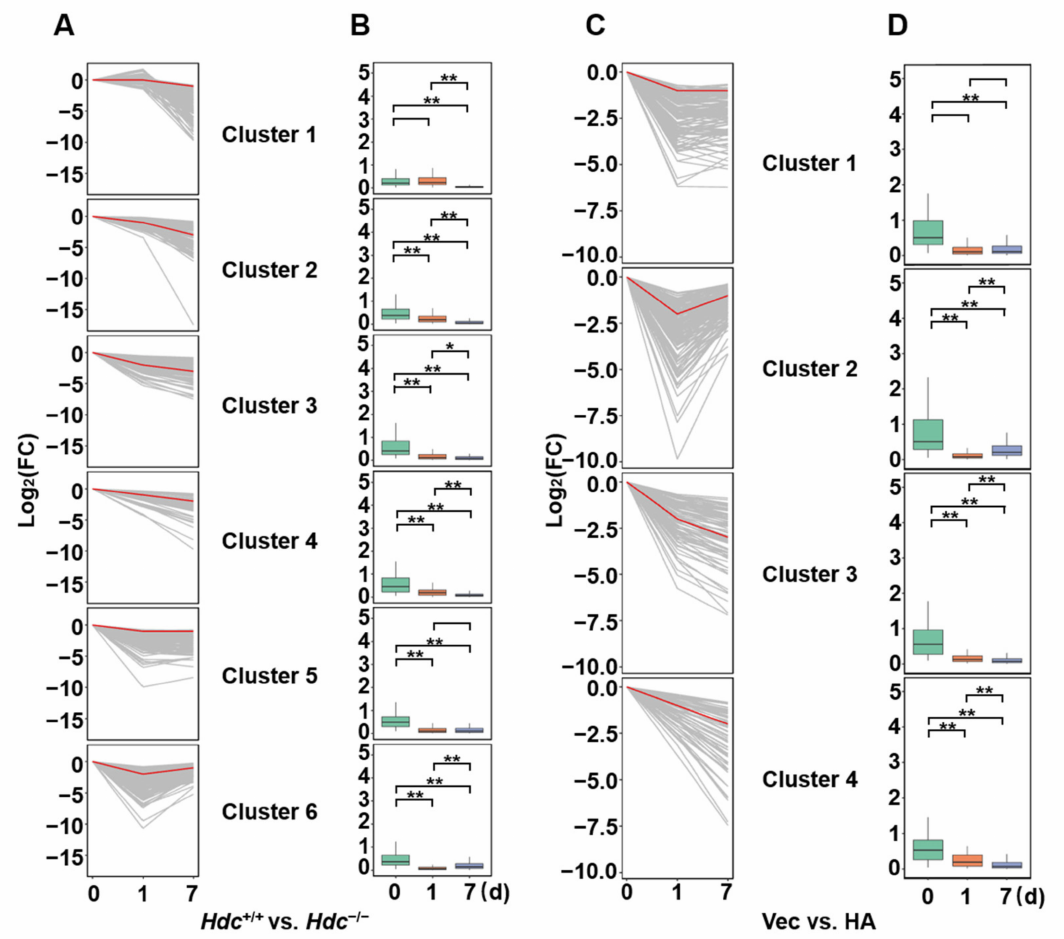
Figure 3. The diagrams depict the patterns of dynamic expression of DEGs. ( A , C ) Gray lines represent individual gene expressions, and red lines represent the summarized values for each pattern. ( B , D ) The diagrams show the change of representative genes during the progression of MI. The green, red and blue boxes represent the relative expression of genes at day 0, 1, and 7 after MI. * p < 0.05, ** p <